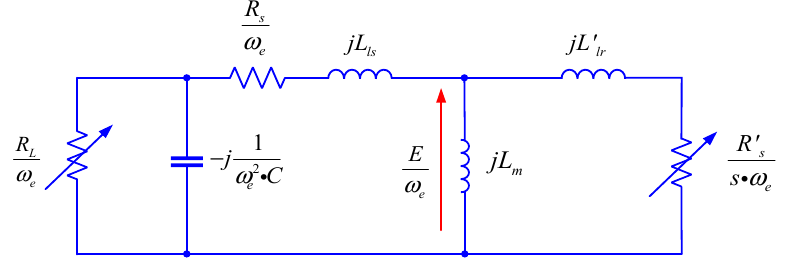
Figure 2. Per-phase equivalent circuit of the self-excited induction generator (SEIG).